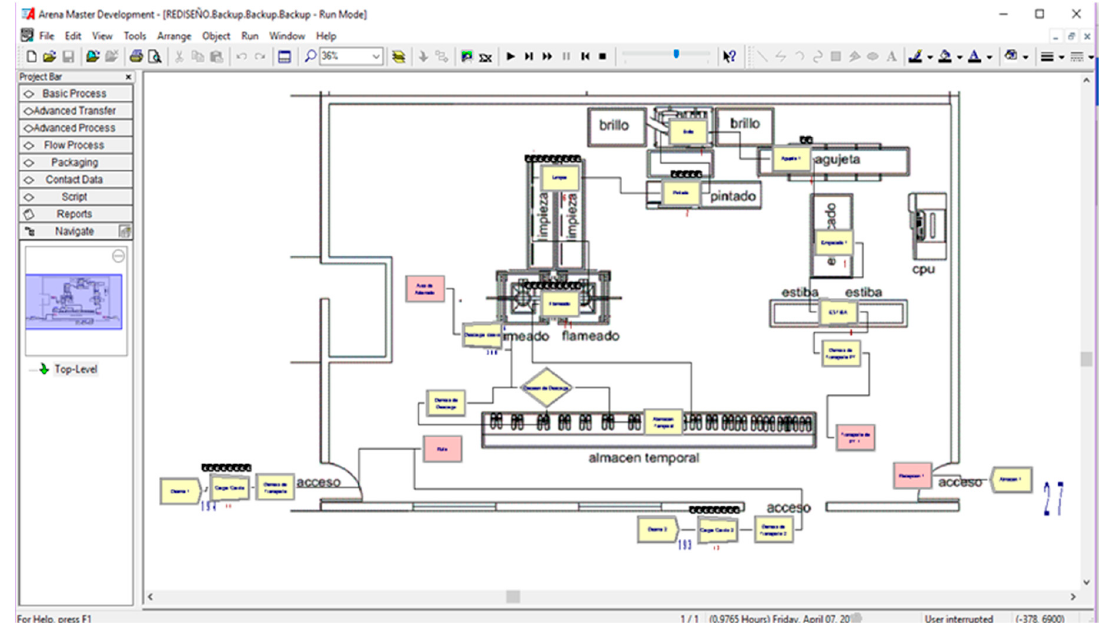
Figure A2. Simulation in process. Proposal. Figure A2 . Simulation in process. Proposal. Figure A2 . Simulation in process. Proposal.